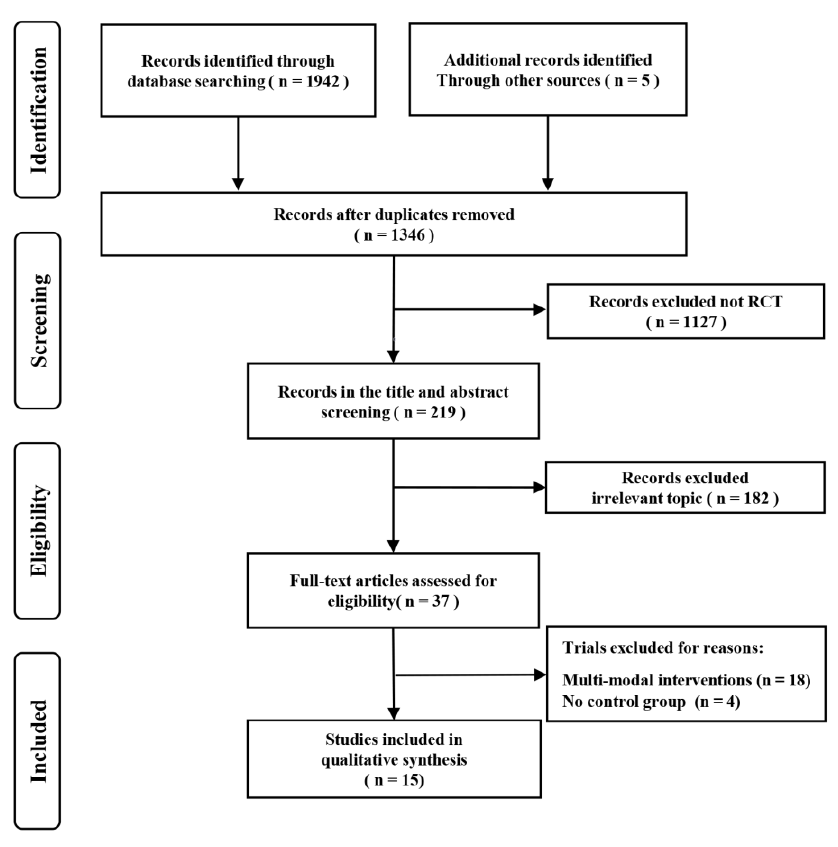
Figure 1. PRISMA flowchart of study selection.